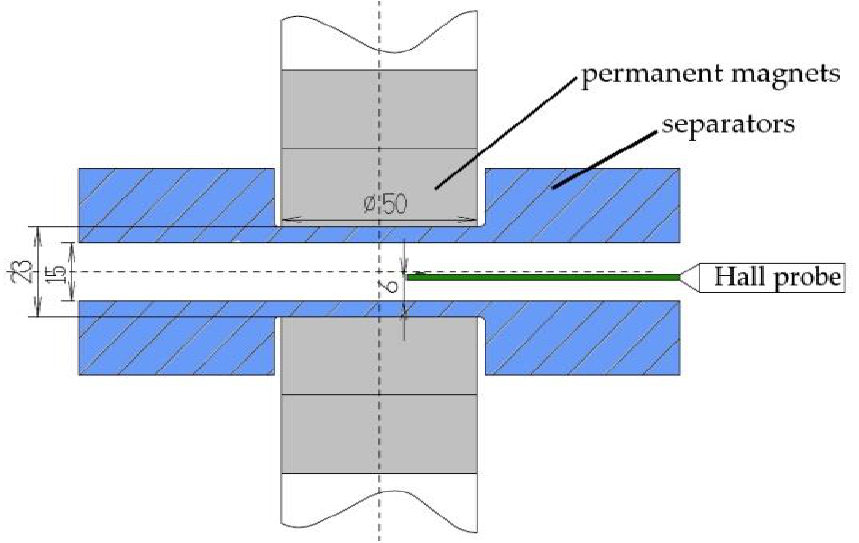
Figure 6. Scheme of measuring the real value of magnetic flux density with the LZ-614H probe in mm.